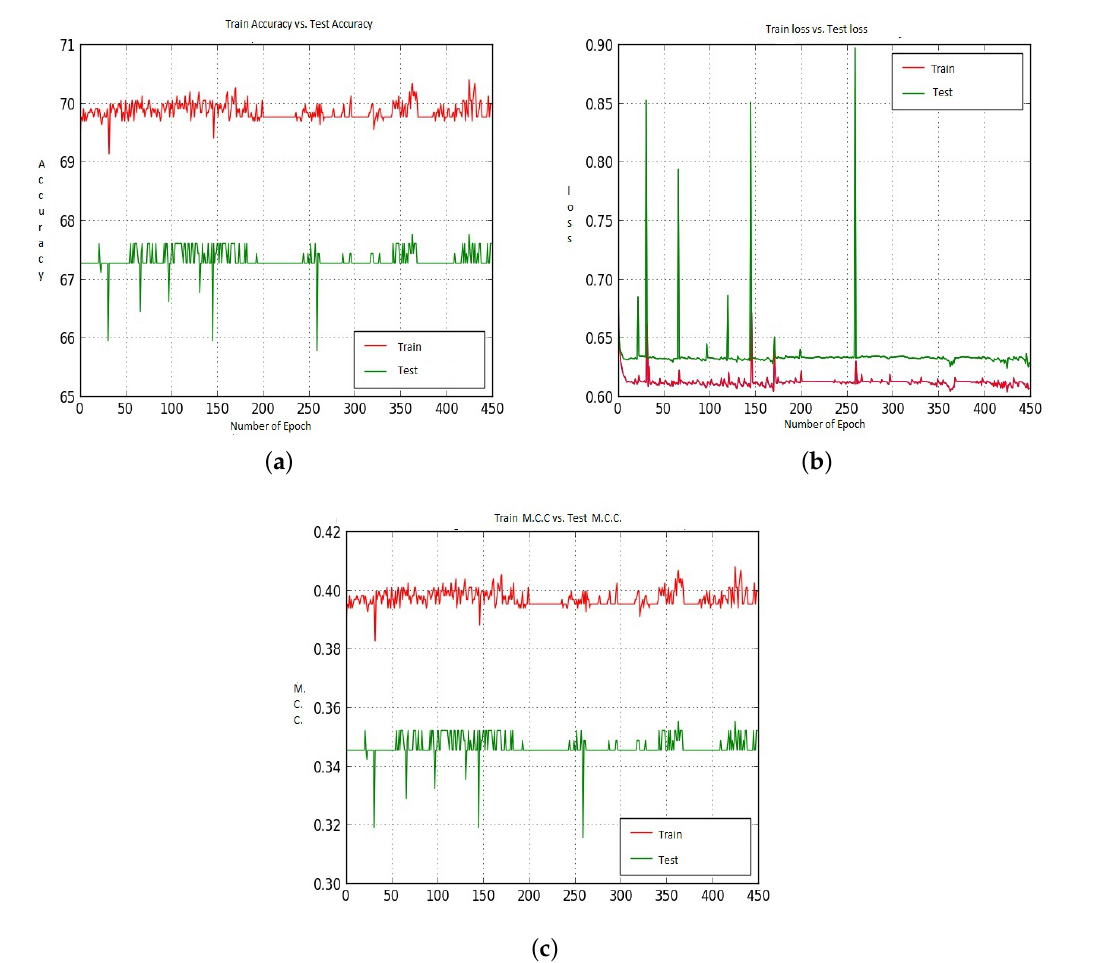
Figure 15. ( a – c ) represent the Train and Test Accuracy, Loss and M.C.C. values when we utilized Model-2, CNN-CH on the 200 ×